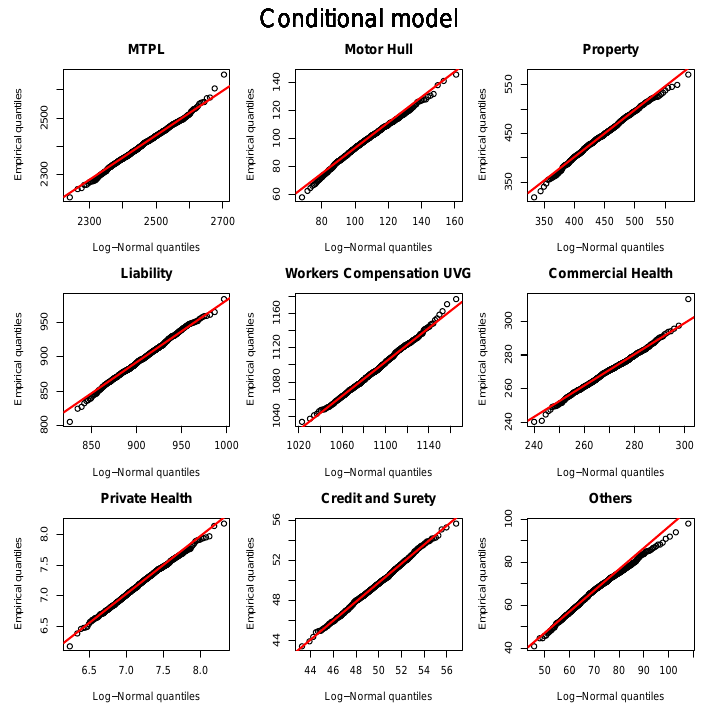
Figure 1. Quantile-Quantile plots for the different lines of business (LoBs) comparing (vertical axis) the empirical distribution of Z PY | σ , F ( t ) based on Model Assumptions 1 and (horizontal axis) the log-normal approximation from Model Assumptions 2. Based on 1000 samples.